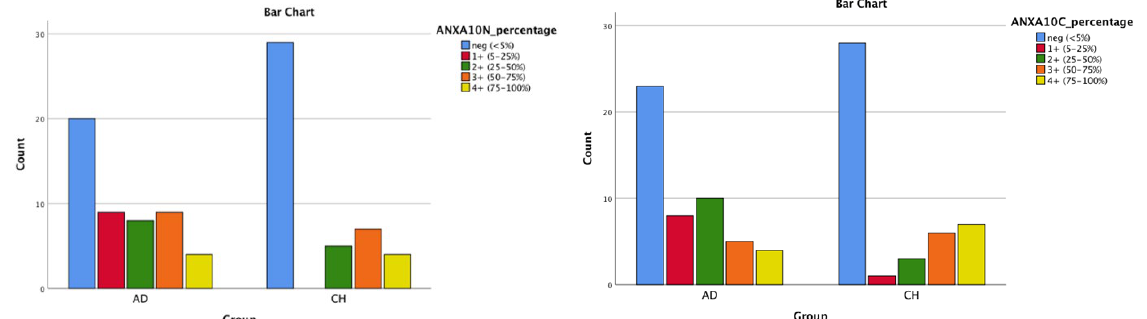
Fig. 4. Bar chart shows AnnexinA10 cytoplasmic positivity in PDA and CCA.